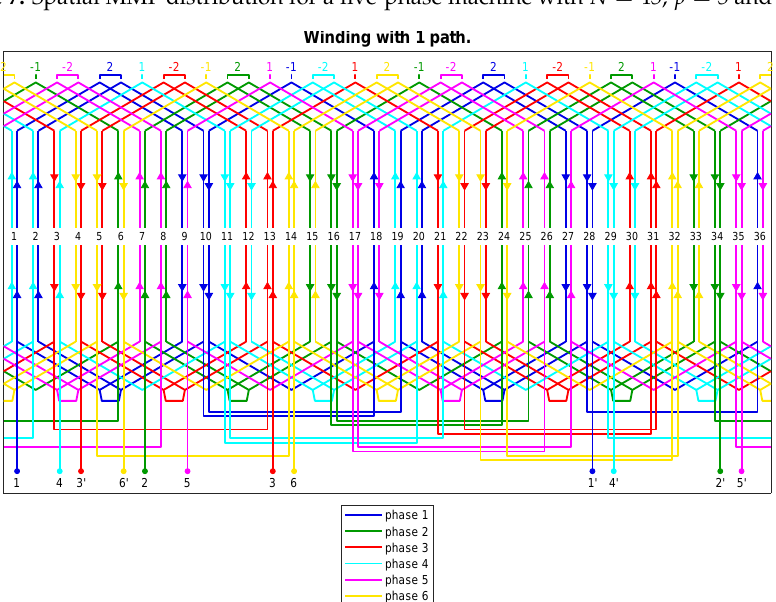
Figure 8. Winding scheme for a six-phase machine with N = 36, p = 2 and y = 2.